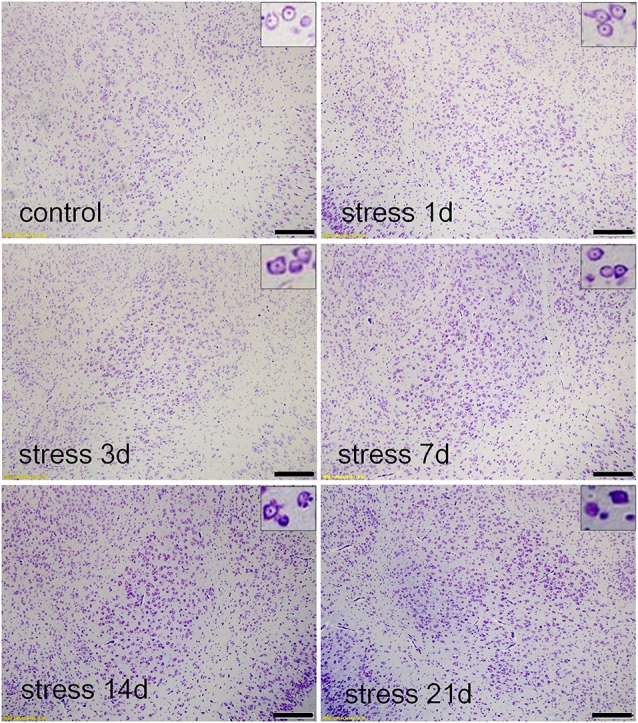
Stress damaged the basolateral amygdala (BLA) neurons. Thionin staining in the control group, and stress groups at 1 day, 3 days, 7 days, 14 daysand 21 days, respectively. High-power photomicrographs in the upper right corners are representative images showing neurons in panels. With increasing periods of stress exposure, Nissl bodies were not clear, neurophagy and pyknotic neurons were visible. Bars = 200 μm.